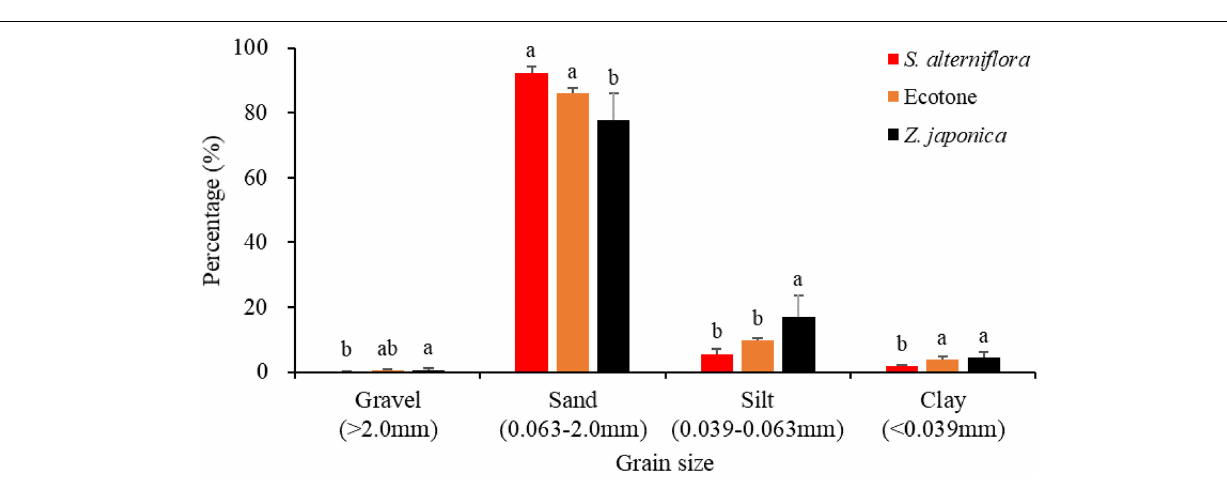
shoot density of Z. japonica decreased with sampling